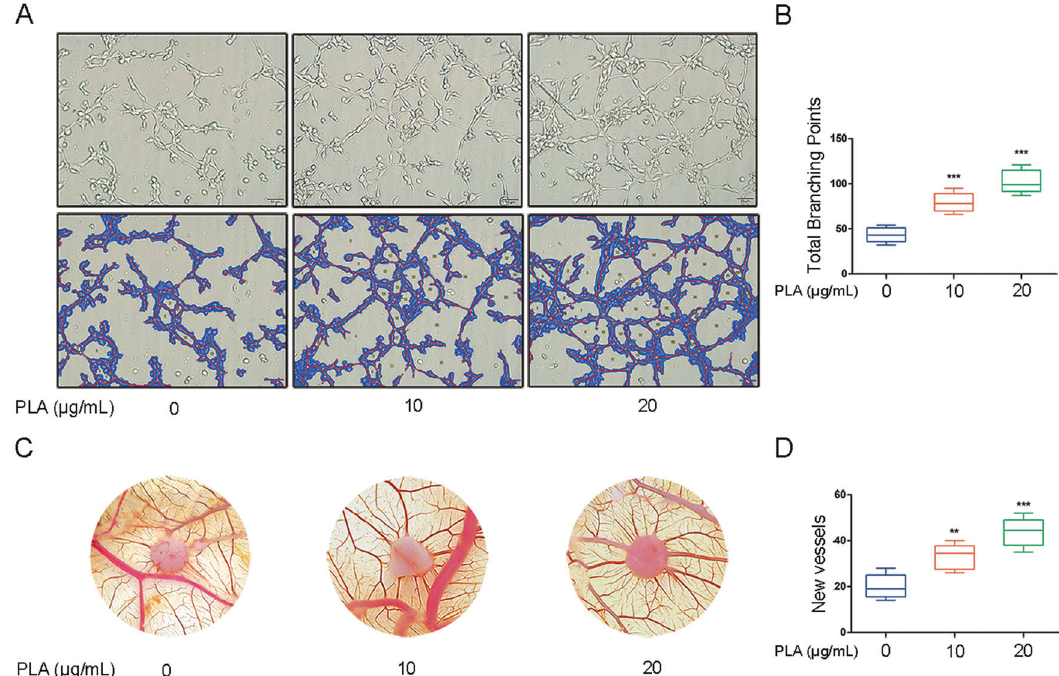
Fig. 6 PLA promotes angiogenesis in vitro and in vivo. A – D NCI-H292 cells were treated with PLA (0, 10, and 20 μ g/mL) for 24 h and the cell- conditioned media were collected for tube formation assay ( A , B ) and CAM assay ( C , D ). For tube formation assay ( A , B ), HUVECs (3.5 × 10 4 ) were mixed with prepared conditioned media and incubated for 12 h on Matrigel. A Representative micrographs of tube formation assay. B Quanti fi cations of total branching points per microscopic fi eld from three independent experiments were analyzed by WimTube. For CAM assay ( C , D ), on EDD 8, sterile gelatin sponges were applied to the CAMs and loaded with 20 μ L prepared conditioned medium twice per day. C Representative images of the CAM blood vessels. D CAM blood vessels entering the sponges were counted by two observers in a double- blind manner. n = 6 chick embryos per group. Results are shown as mean ± SD. ** P < 0.01; *** P <